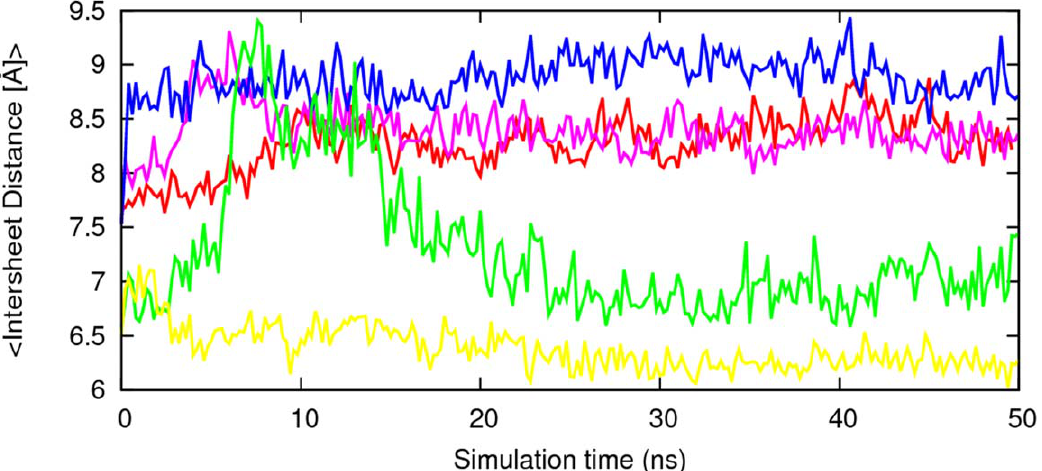
Figure 4. Time evolution of sheet-to-sheet distances. The inter-sheet distances for the models 16–21, 27–32, 30–42 and 35–42 were calculated by averaging the mass center distance between backbone residues of 16–21, 27–32, 30–42 and 35–42 respectively. The results are the average of two independent simulation of each system. Red, 16–21P; green, 16–21AP; blue, 27–32; pink, 35–42; cyano, 30–42.